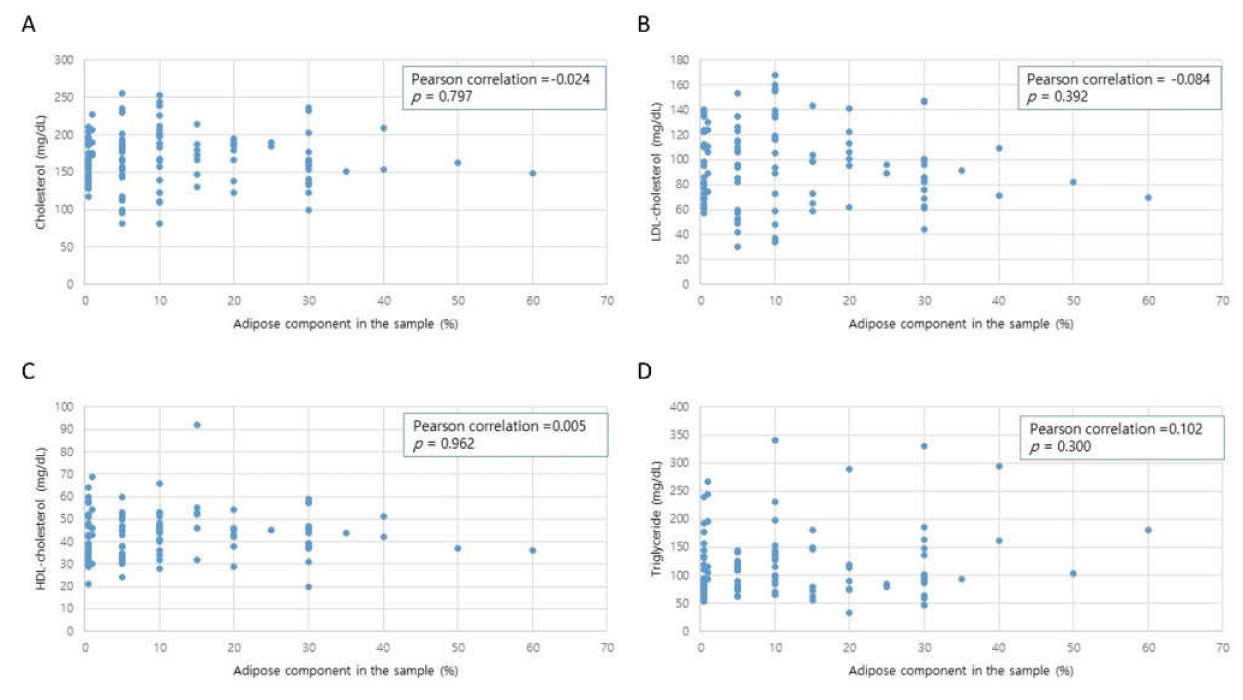
Figure 2. Linear correlation analysis between the adipose component and the laboratory lipid profiles (( A ) total cholesterol; ( B ) low-density lipoprotein cholesterol; ( C ) high-density lipoprotein cholesterol; ( D )